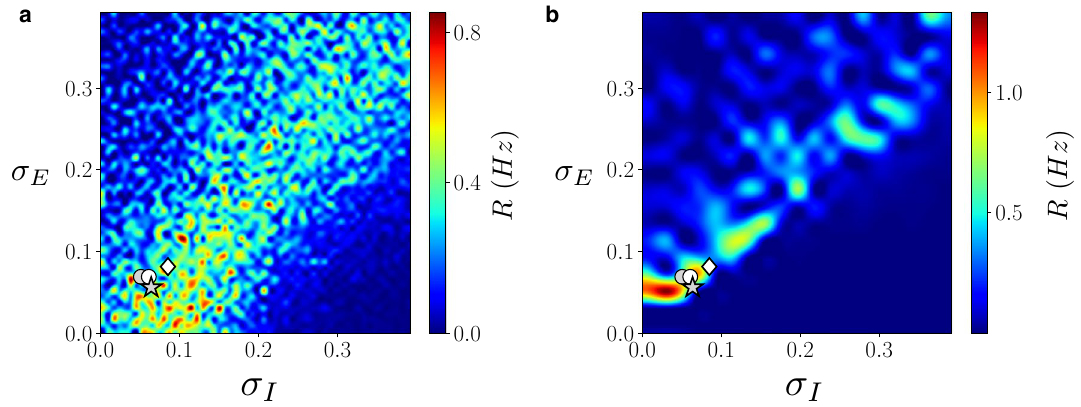
Figure 2. Excitatory and inhibitory heterogeneity determines network responsiveness. ( a ) Responsiveness R as a function of heterogeneity of excitatory ( σ E ) and inhibitory ( σ I ) neurons for networks displaying relatively high levels of spontaneous activity (input baseline ν 0 = 1.5 Hz and input amplitude A = 1 Hz). ( b ) Responsiveness R for networks with a lower level of spontaneous activity (input baseline ν 0 = 0.4 Hz and input amplitude A = 0.6 Hz). Different markers correspond to heterogeneity values estimated from Human cortex layer 2, 3 (white circle), Human cortex layer 5, 6 (grey circle), mouse cortex layer 2/3 (grey star) and mouse cortex layer 6 (white diamond) estimated from Allen Brain database 32 , see Fig.